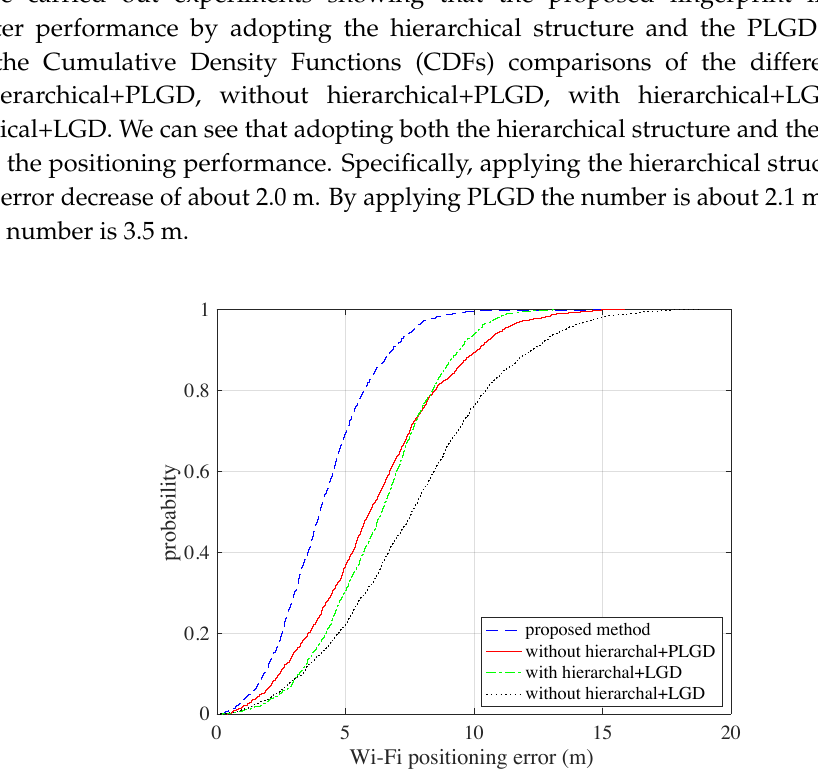
Figure 6. Wi-Fi fingerprinting based positioning results comparisons using different